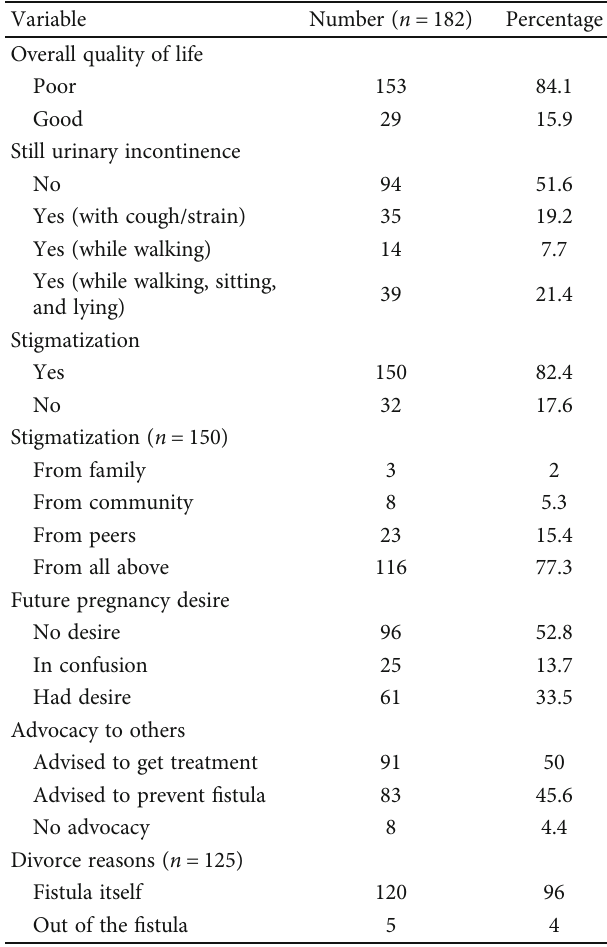
Table 3: Overall and interpersonal quality of life among fi stula survivors ( n = 182 ), central Gondar districts, Northwest